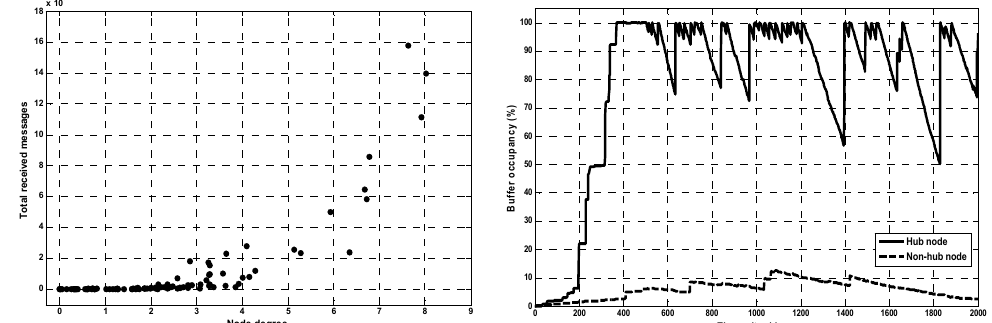
Figure 3. ( left ) Node degree vs. node traffic load, and ( right ) the buffer queue growths of illustrative hub node and non-hub node, when the hill-climbing heuristic forwarding is used in the mobile social network. This describes an imbalanced traffic load among nodes, with the highest degree nodes handling the bulk of network traffic, resulting in significant buffer occupancy throughout the simulation.